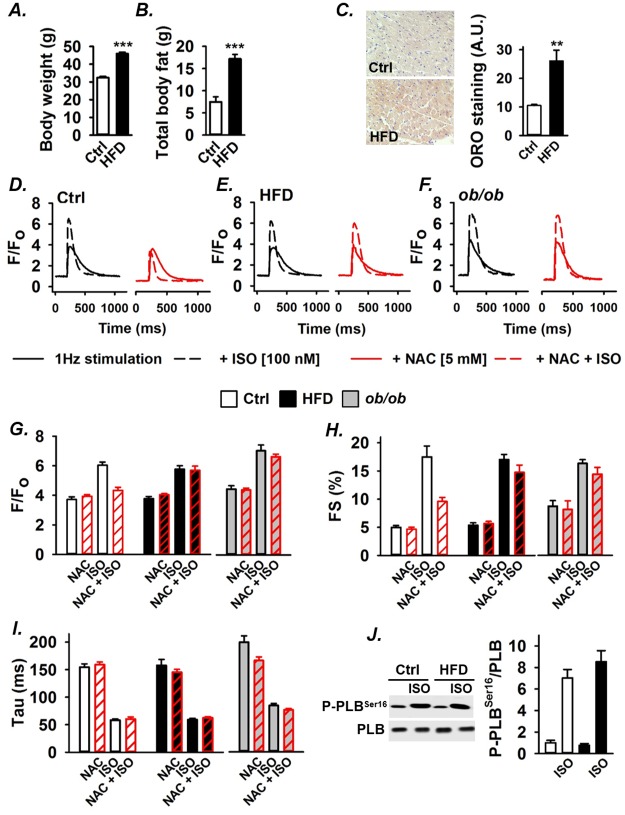
The antioxidant NAC has no effect on the β-adrenergic stimulated SR Ca2+ release and contractility in cardiomyocytes from mice with the metabolic syndrome.(A) Total body weight of mice after 8–10 weeks on control diet (Ctrl, n = 34) or high fat diet (HFD, n = 40). (B) Total body fat measured with DXA whole-body scan (n = 9–10). (C) Typical example of cross-sectional ORO staining showing fat accumulation (stained red) in left ventricles and mean data of ORO staining; eight sections per left ventricle from each group were analyzed (n = 3). Representative [Ca2+]i transients from ctrl (D), HFD (E) and ob/ob
(F) cardiomyocytes obtained in the absence (full lines) and presence (dashed lines) of ISO (100 nM), and without (black lines) and with (red lines) NAC (5 mM). Average amplitude of Ca2+ transients (G), fractional cell shortening (FS, H) and [Ca2+]i transient decay time constant (tau) (I) with ISO and/or NAC as indicated from control (white bars), HFD (black bars) and ob/ob (grey bars) cardiomyocytes (n>16 cells from at least three mice). Representative Western blots (J) and mean data (n = 6) of ISO-induced PLB phosphorylation normalized to total PLB expression in left ventricles from control and HFD mice. Data are mean ± SEM; **P < 0.01, ***P < 0.001.